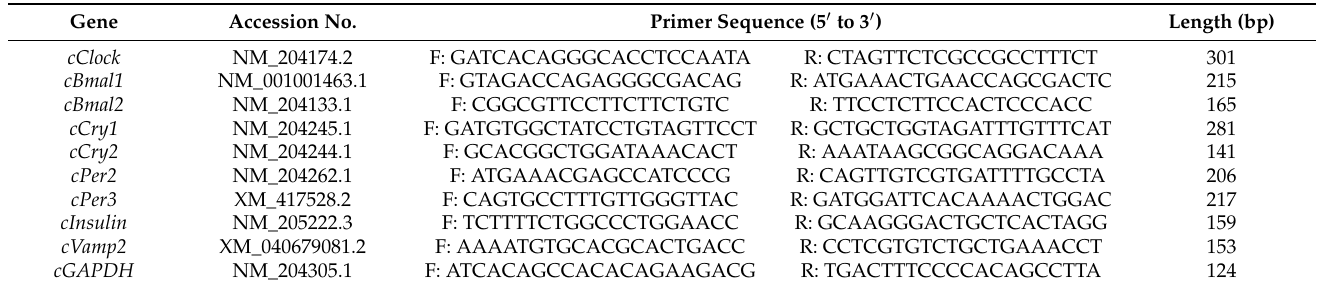
Table 1. Primers used for real-time PCR analysis and expected product